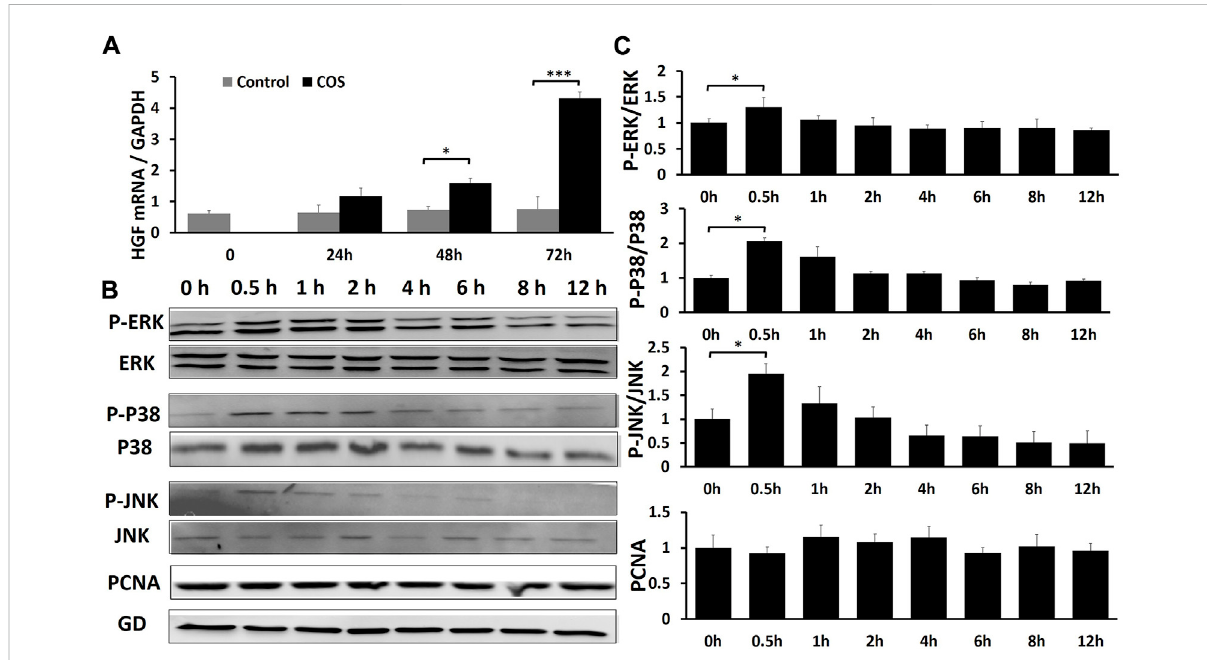
FIGURE 9 COS can promote wound healing through MAPK pathway and growth factor HGF (A) The qRT-PCR indicated that COS may promote wound healing by promoting the expression of HGF. (B) Western blotting assays demonstrated that COS stimulated phosphorylation of MAPK proteins (P-ERK1/2,P-p38andP-JNK)within0.5 h. (C) Quanti fi cationoftheresultsfromtheqRT-PCRandWesternblottingassaysisshowninthe fi gure.* p < 0.05, *** p <